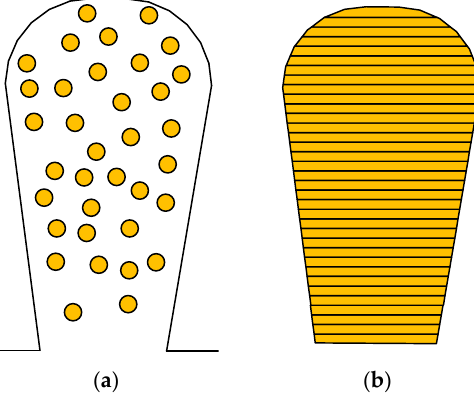
Figure 4. Cross section of wires in one slot. ( a ) Real model. ( b ) Equivalent model.